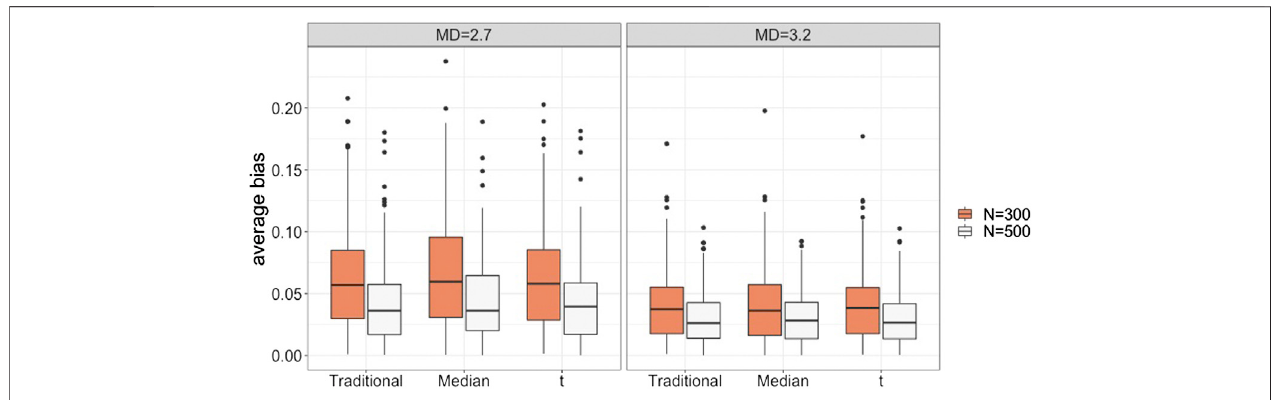
FIGURE 2 | Average absolute bias for the traditional, the median-based, and the t -based GMM in conditions with varied degrees of latent class separation and sample